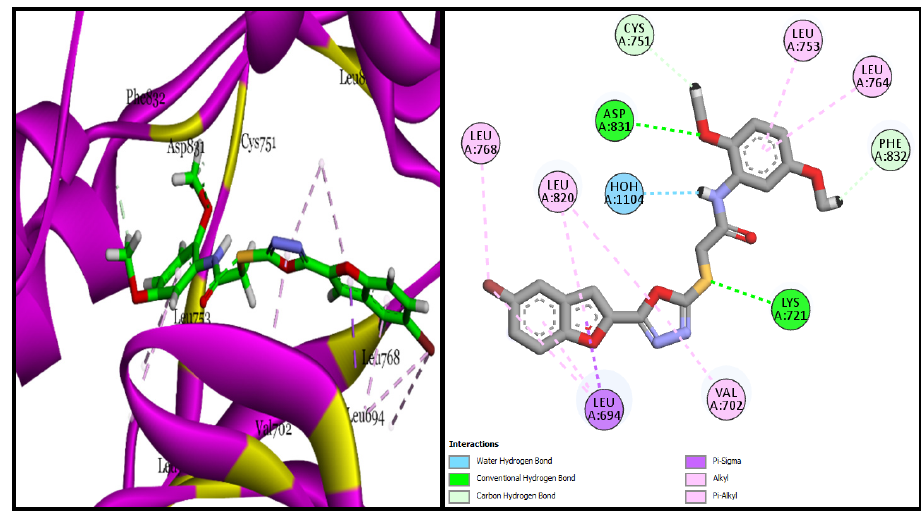
Figure 5. Three-dimensional and Two-dimensional interaction images of the BF-5+EGFR Protein complex.